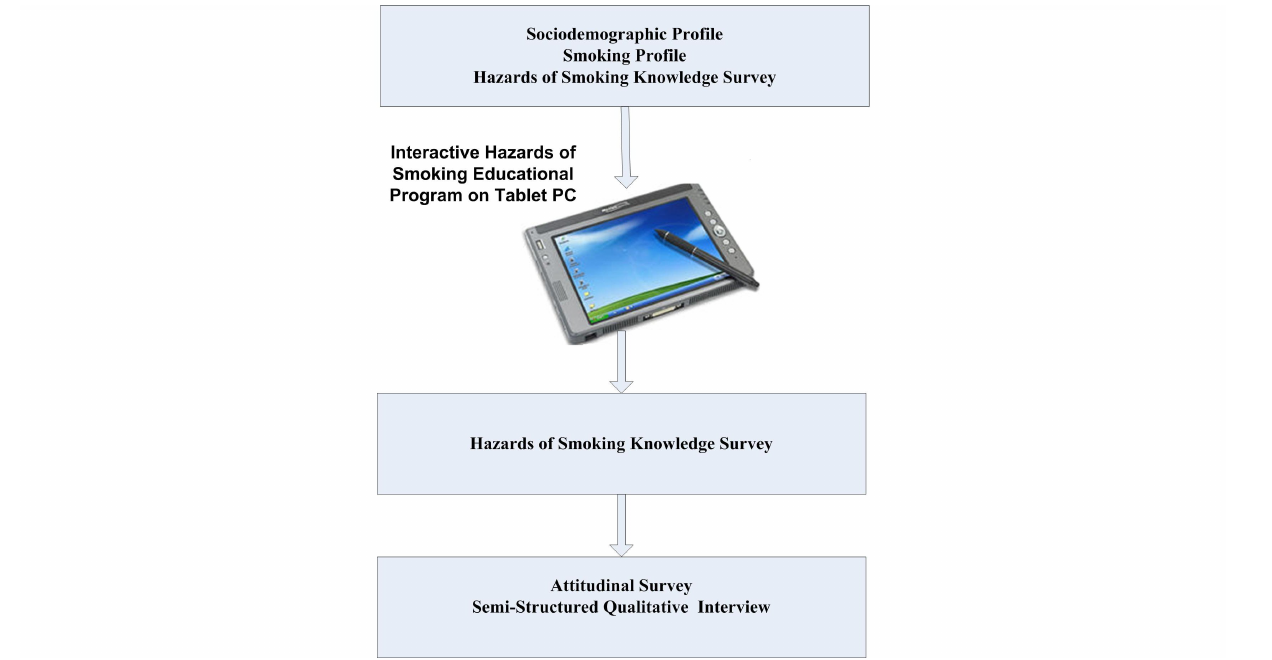
Figure 2. The design of the